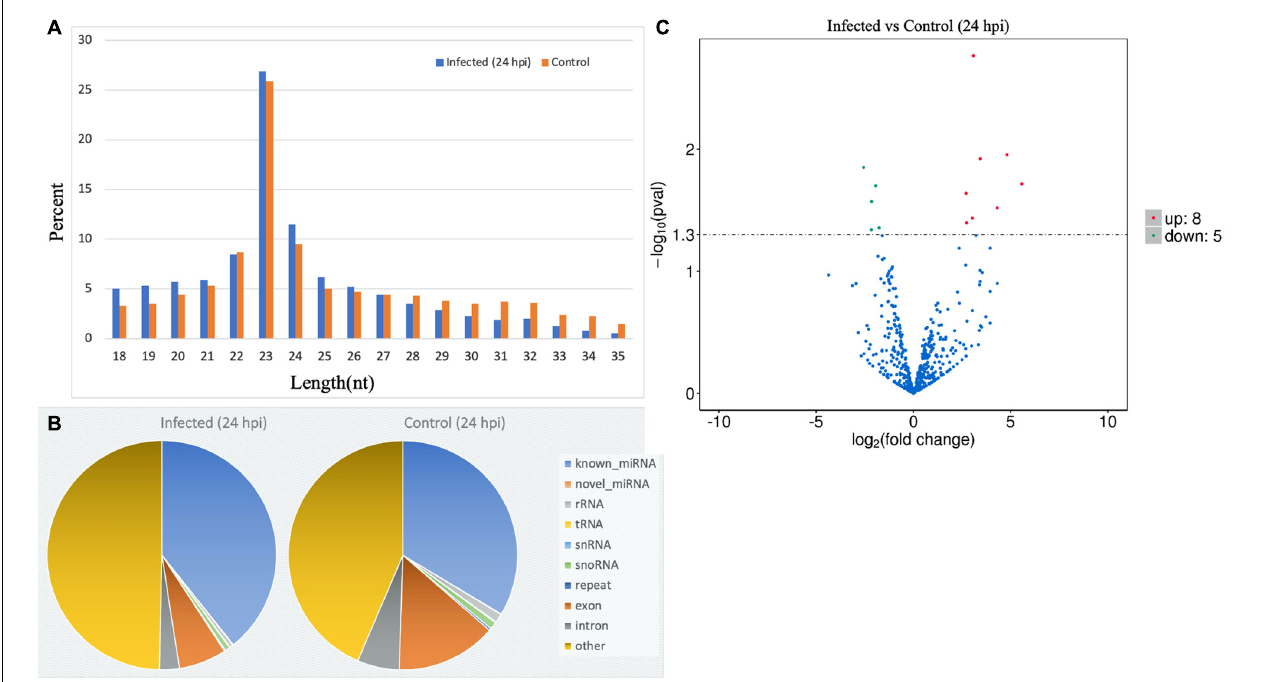
FIGURE 4 | MicroRNA (miRNA) expression profiles of bovine rotavirus (BRV)-infected cells in comparison with the control (24 hpi). (A) Length distributions of total small RNA (sRNA) segments: the length of reads proportional to the reads of that length (23 nt was the main observed length). (B) Pie chart showing the total read distributions of sRNAs and their categories (e.g., known miRNAs, novel miRNAs, rRNA, tRNA, snRNA, snoRNA, repeats, exons, introns, etc.). (C) Volcano chart representing the expression change of the miRNAs between the virus-treated and normal non-treated cells. The x -axis shows the log2(fold change) and the y -axis shows the − log10 ( q -Value). The horizontal dotted lines in the figure correspond to the q -Value (default) or the adjusted p -Value (FDR), with 0.05 as the significant difference threshold. Significant difference thresholds: log2(fold change) > 1 and FDR-adjusted p = 0.05. Upregulated miRNAs are represented by red dots , downregulated miRNAs by green dots , and miRNAs with no significant changes by blue dots